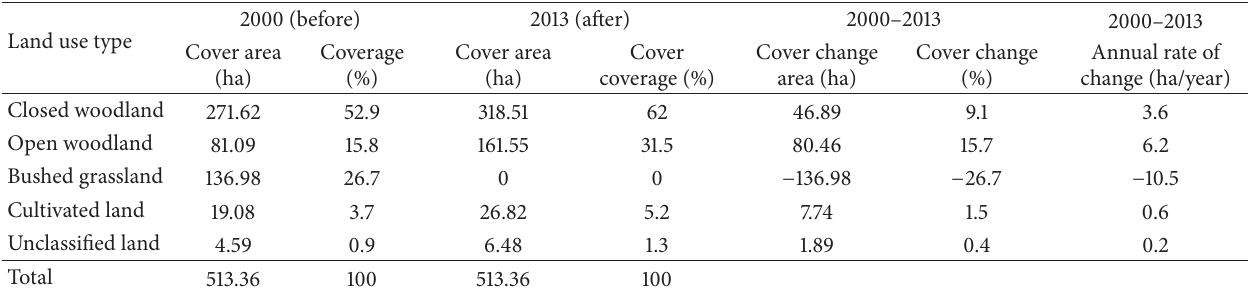
Table 6: Land use and miombo cover change before and after CBFM,